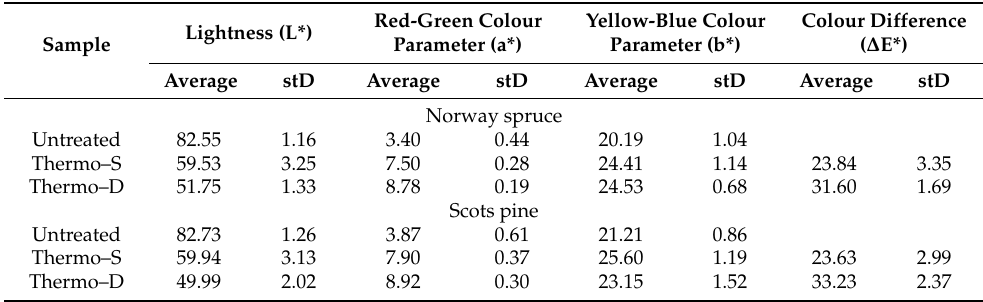
Table 1. Colour measurements for untreated, Thermo–S, and Thermo–D Norway spruce and Scots pine wood. stD—standard